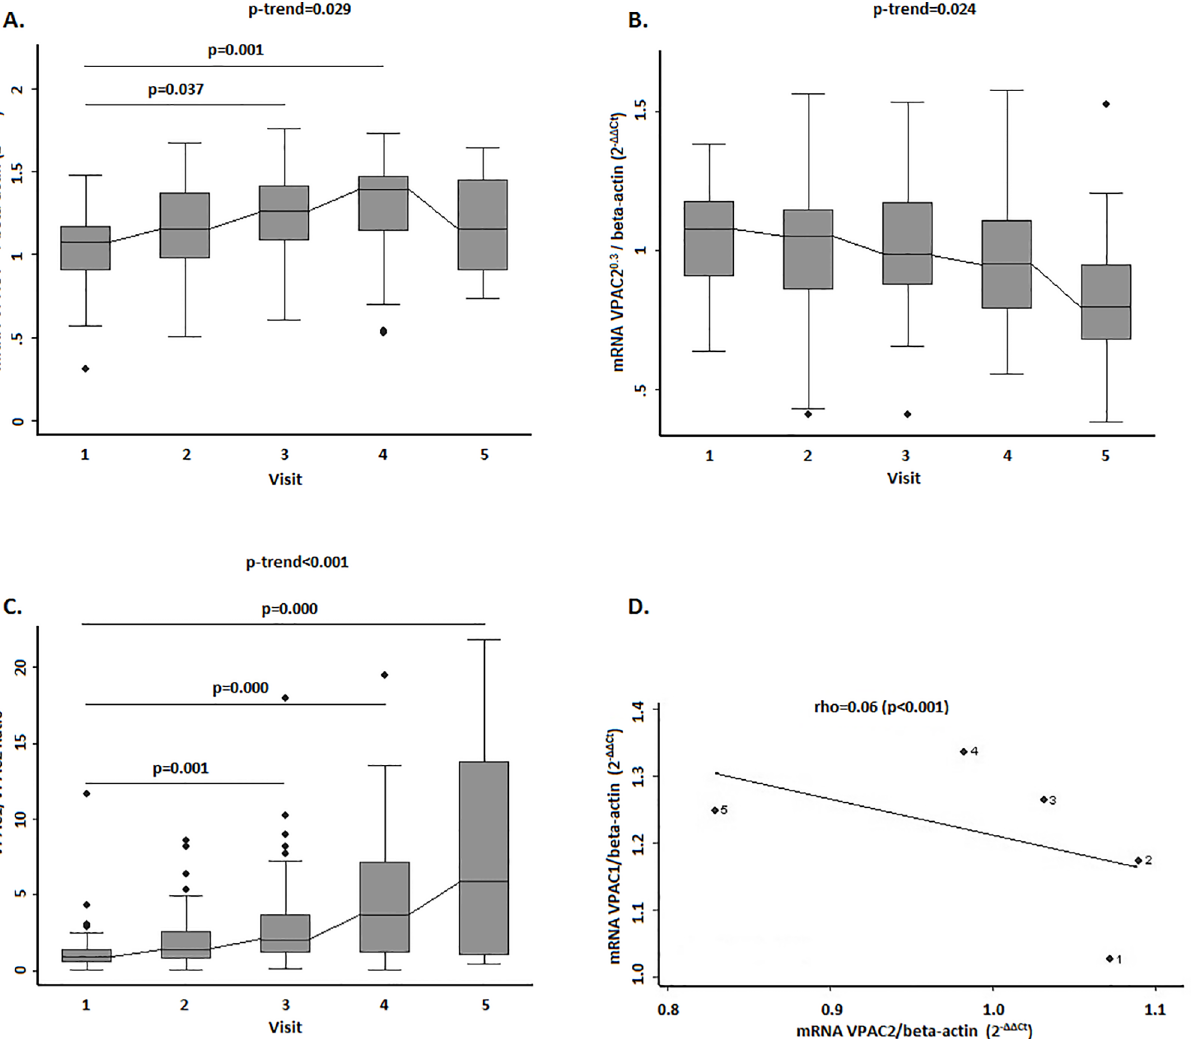
Fig 2. Evolution of gene expression levels of VPAC1 and VPAC2 in PBMCs from EA patients. (A) and ( B) Variation in gene expression levels of VPAC1 (panel A) and VPAC2 (panel B) receptors at follow-up visits. (C) Evolution of the ratio of gene expression of both receptors during the follow-up. (D) Correlation between gene expression levels of VPAC1 and VPAC2 receptors. Statistical significance was established using the Trend test and non- parametric posteriori test (Dunnett) for intergroup comparison, in panels A, B and C. In panel D, the significance level was obtained by means of a generalized linear model nested by patient and visit. In panel D dots represent average data from patients clustered by visits from 1 to 5. Data of A, B and C panels are represented as the interquartile range (p75 upper edge of the box, p25 lower edge, p50 midline), p90 (line above the box), and p10 (line below the box) of the expression of VPACs receptors. Mathematical transformation for VPAC expression: raised to 0.3. Dots represent outliers.